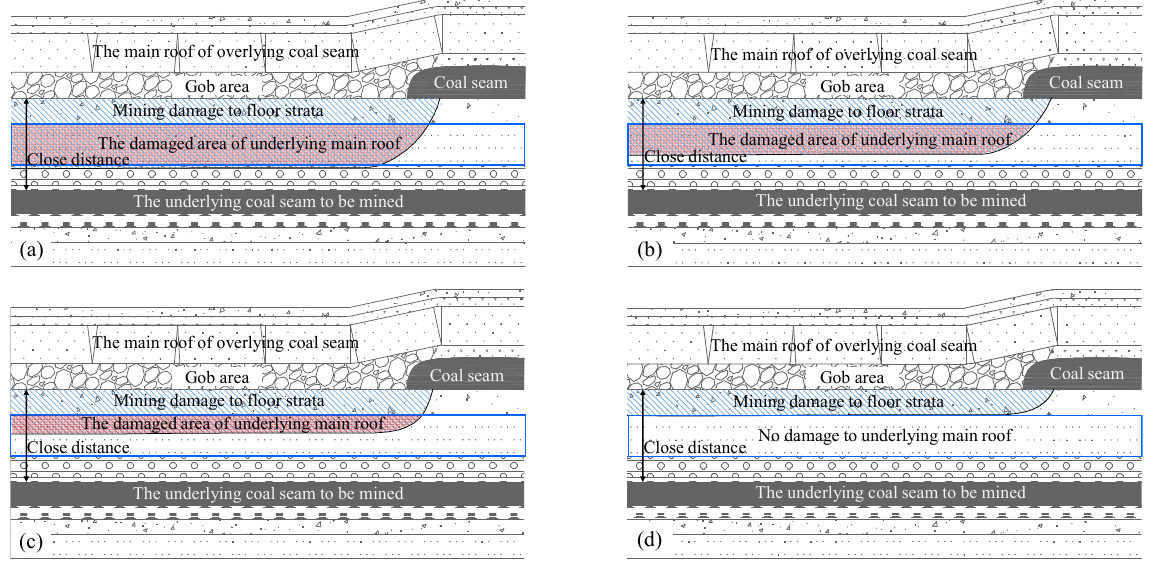
Figure 3. Four types of damaged main roof in the lower coal seam. ( a ) Complete damage to the lower main roof ( b ) Wide area damage of the lower main roof ( ≥ 50%) ( c ) Local damage to the lower main roof (<50%) ( d ) No damage to the lower main roof.